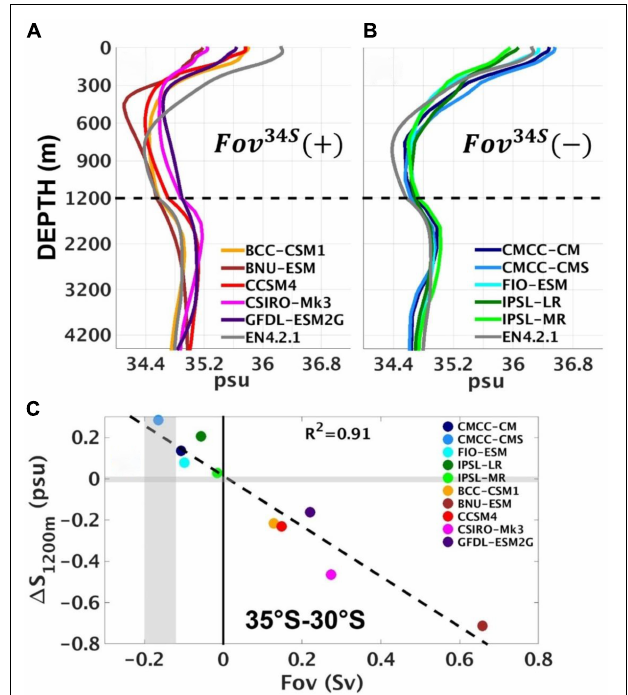
FIGURE 1 | The zonally averaged salinity profiles between 34 ◦ S and 20 ◦ S for the 10 chosen CMIP5 models, divided into groups with (A) positive and (B) negative F ov 34 S . The EN4.2.1 observations are also shown for comparison. Note the stretched vertical axis in (A,B) between 0 and 1200 m, compared to 1200 and 4500 m. (C) Scatter plot of mean (cid:49) S 1200m and F ov between 35 ◦ S and 30 ◦ S for the 10 chosen CMIP5 models. The vertical grey shading represents F ov observational range in the southern Atlantic from Garzoli et al. (2013), whereas the horizontal grey shading corresponds to the small annual range of EN4.2.1 (cid:49) S 1200m ∼ 0.02